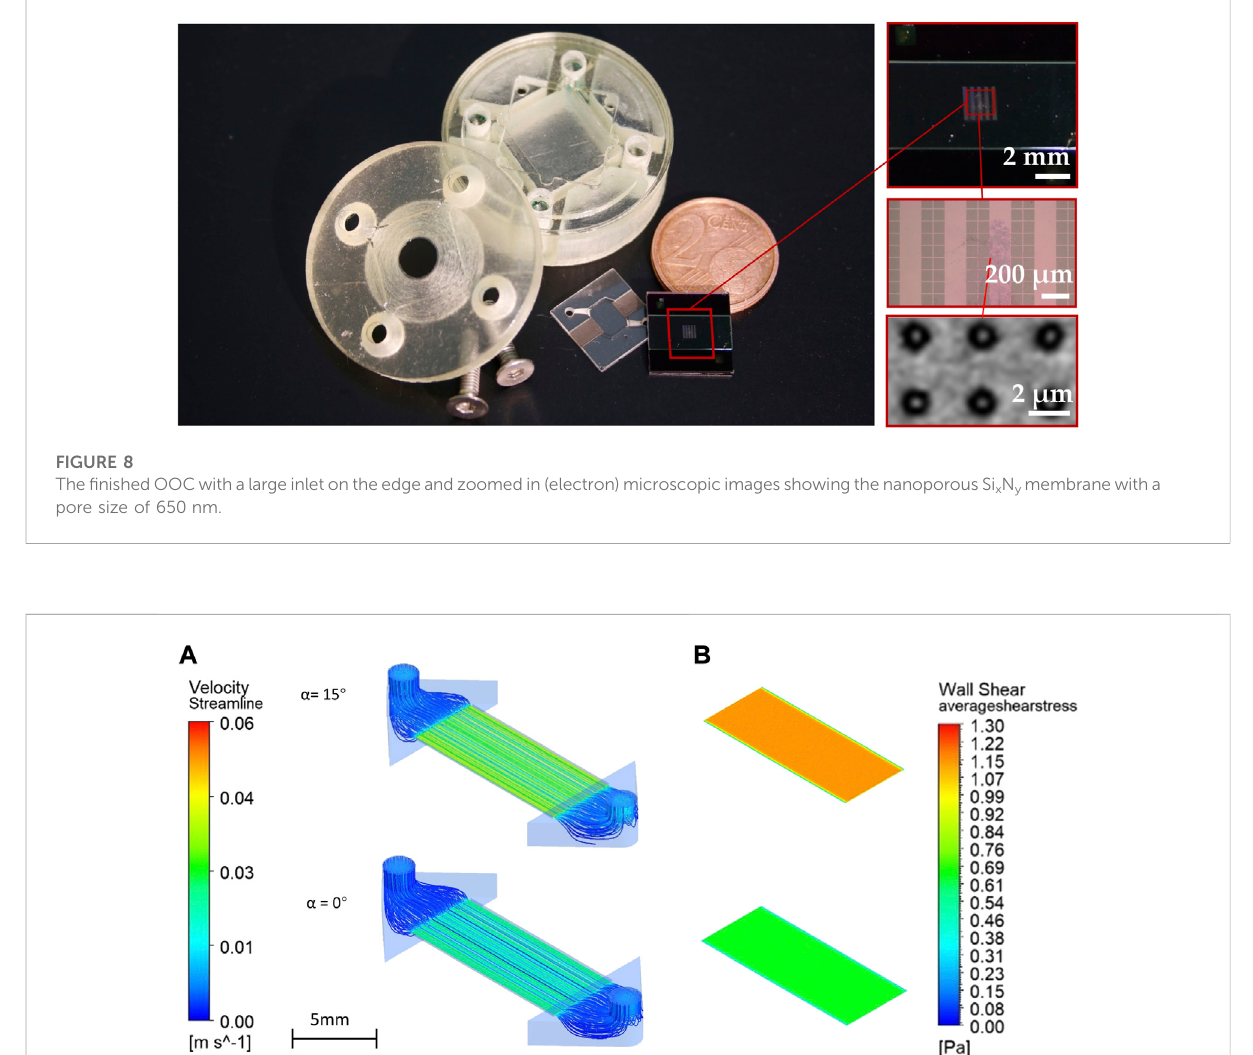
FIGURE 9 Velocity pro fi les(streamlinesshown areatdifferentchannelheights) intheupperchannelcompartment (A) and shearstressdistributionsatthe surface of the nanoporous Si x N y membrane (B) as obtained with CFD simulations assuming gravity at α = 15 ° and α = 0 °